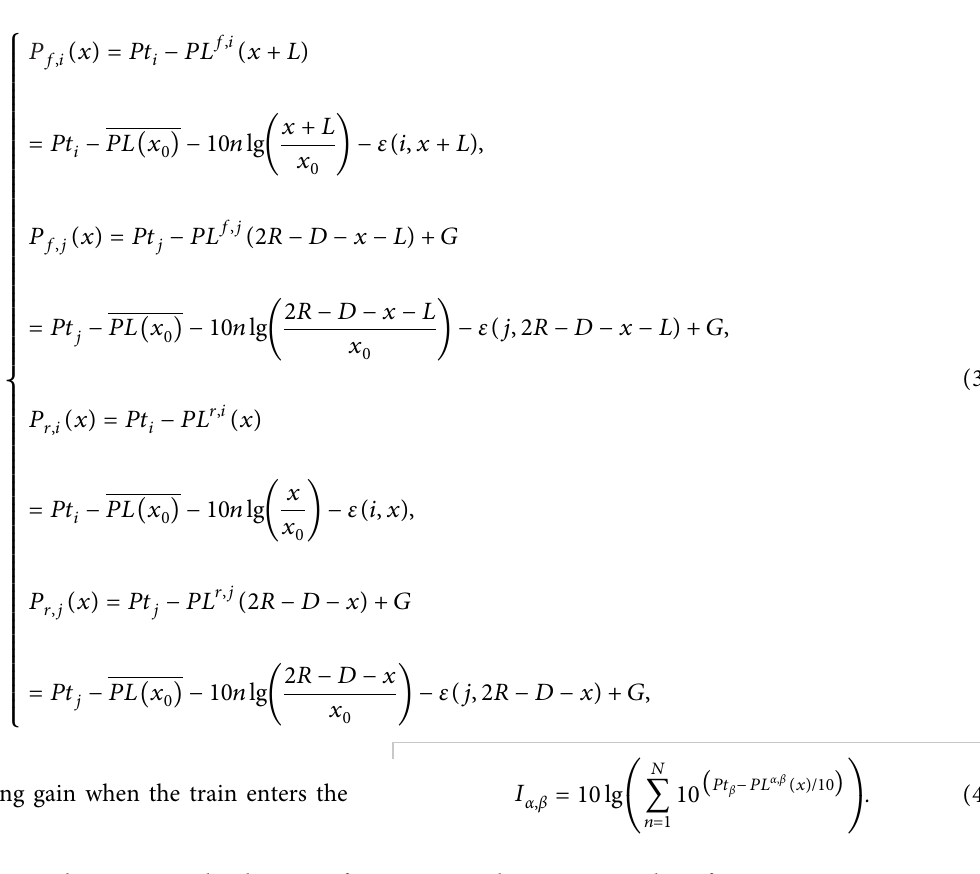
Figure 2: Parameters related to the quality of received